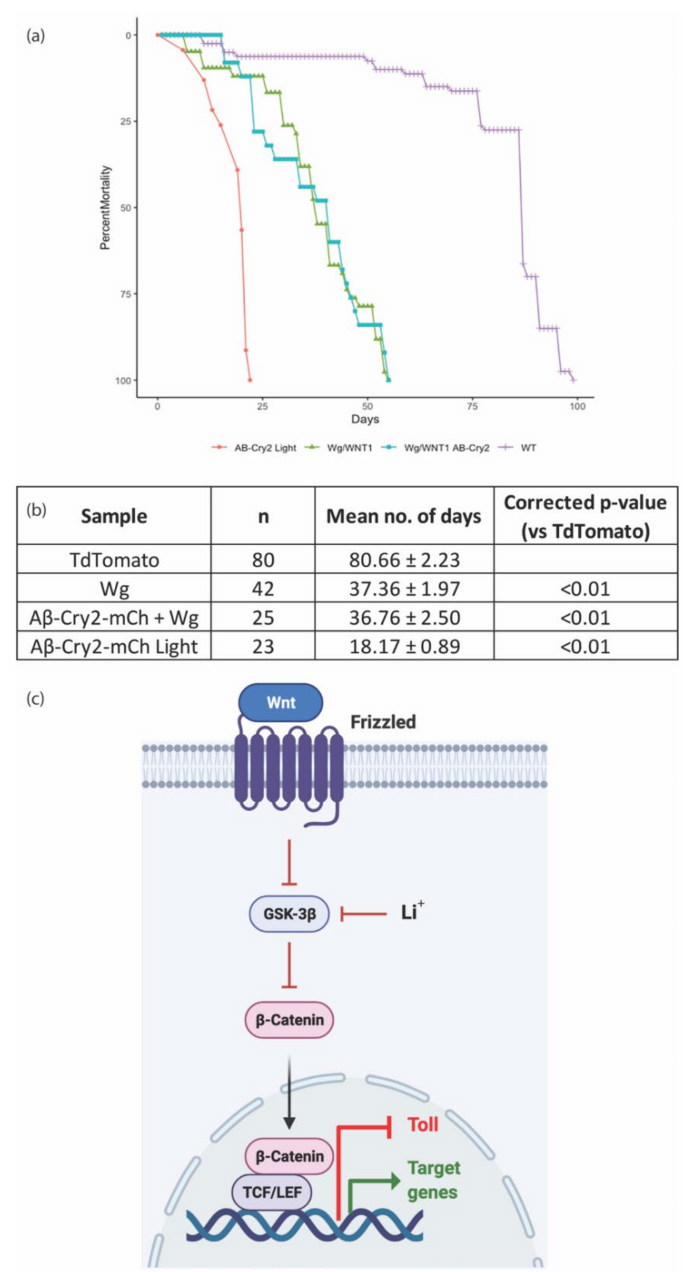
Figure 4. Lifespan decrease rescued by Wnt expression. Lifespan analysis of flies expressing TdTomato (control), Wg, A β -CRY2-mCh + Wg and A β -CRY2-mCh in gut stem cells. Genotype: TdTomato — esg-Gal4>UAS-GFP, UAS-Td-Tomato; Wg —esg-Gal4> UAS-GFP, UAS-wg, A β -CRY2-mCh + Wg — esg-Gal4> UAS-GFP, UAS-wg, UAS-A β 1-42 -CRY2-mCh; A β -CRY2-mCh —esg-Gal4> UAS-GFP, UAS- A β 1-42 -CRY2-mCh. ( a ) The lifespan curves for the various genotypes, and ( b ) table showing the number of subjects with mean lifespans and p -values. ( c ) Diagram showing lithium-induced activation of the Wnt pathway inhibiting Toll signalling. Raw data provided in Supplemental Table